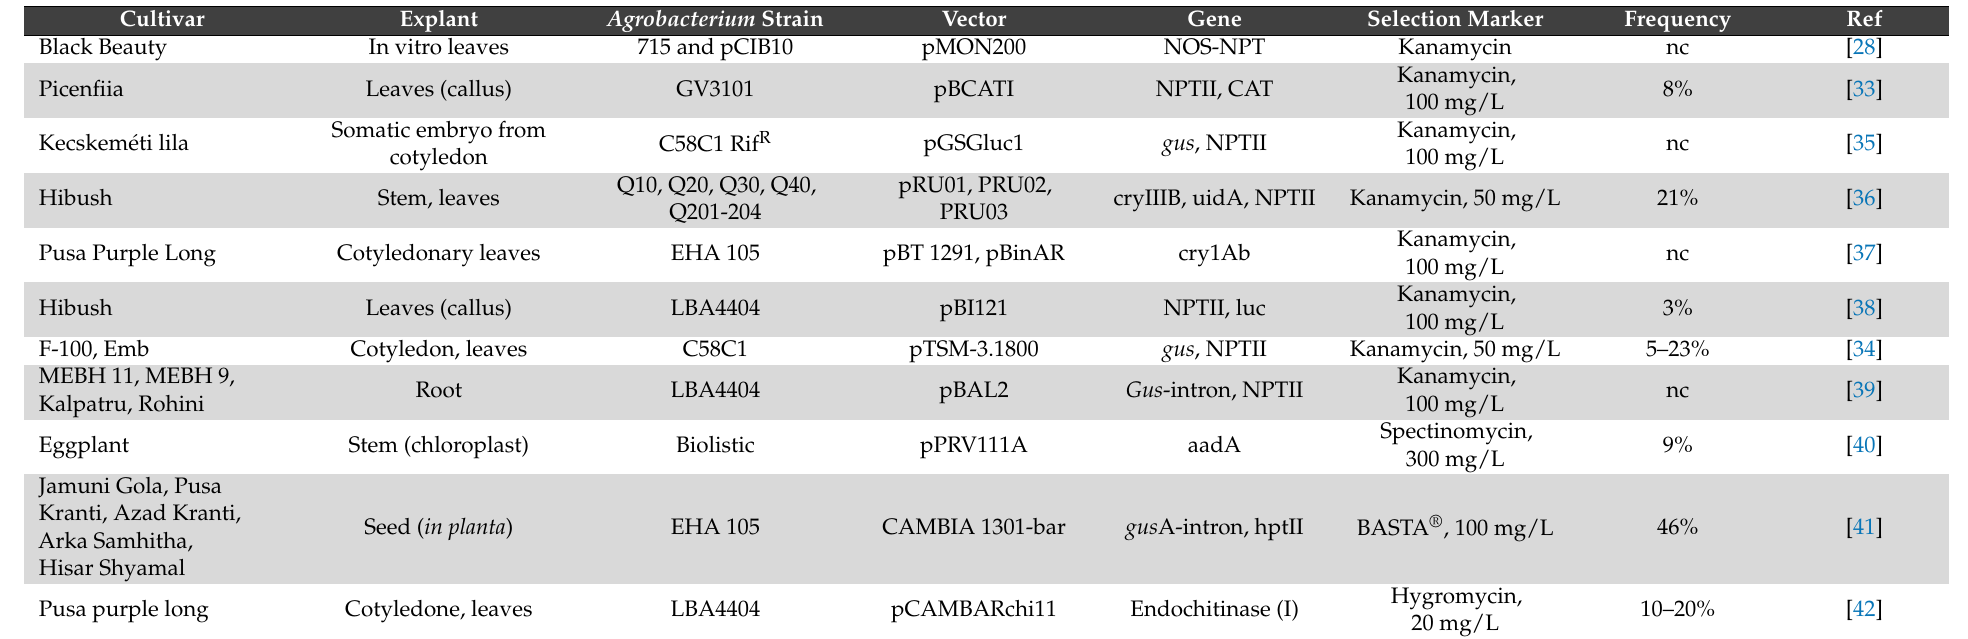
Table 2. Common factors tested for the Agrobacterium -mediated and biolistic genetic transformation in